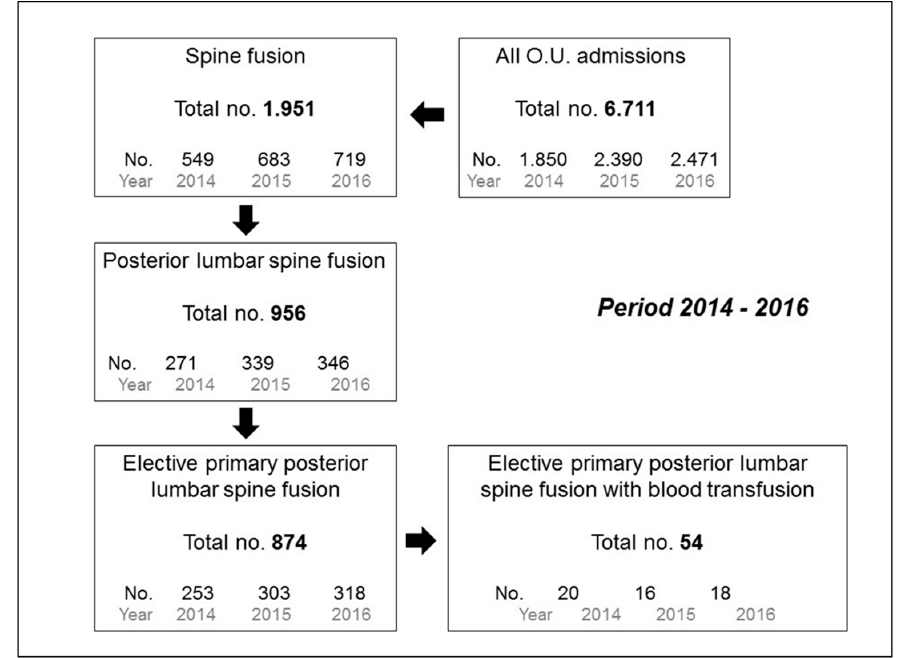
Figure 1. Flowchart showing the number of admissions at the operative unit (O.U.) Neurosurgery I, spine fusions, and posterior lumbar spine fusion surgeries over the three years of observation.